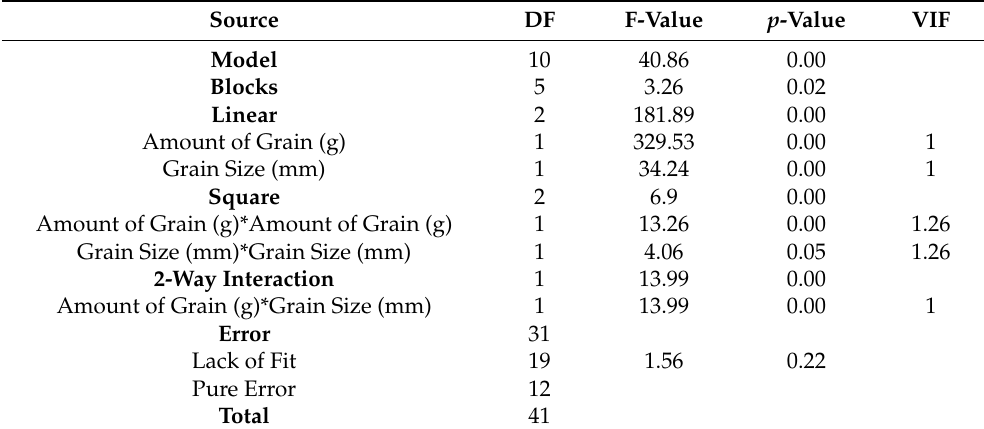
Table 3. Analysis of variance (ANOVA) for alcohol yield from response surface methodologies analysis based on grain amount and size. This table indicates both p -value and VIF.